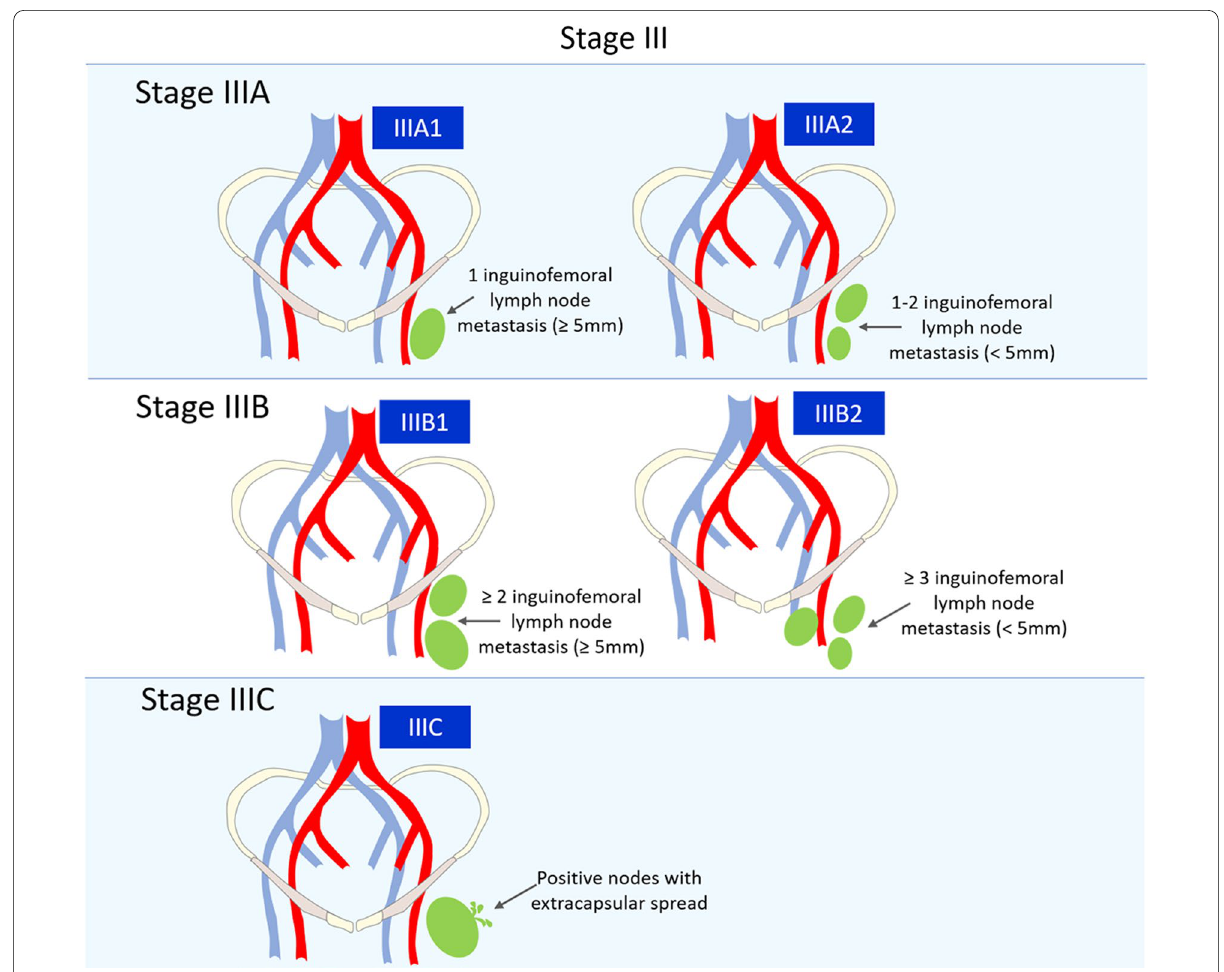
Fig. 6 Schematic illustration of FIGO stage III